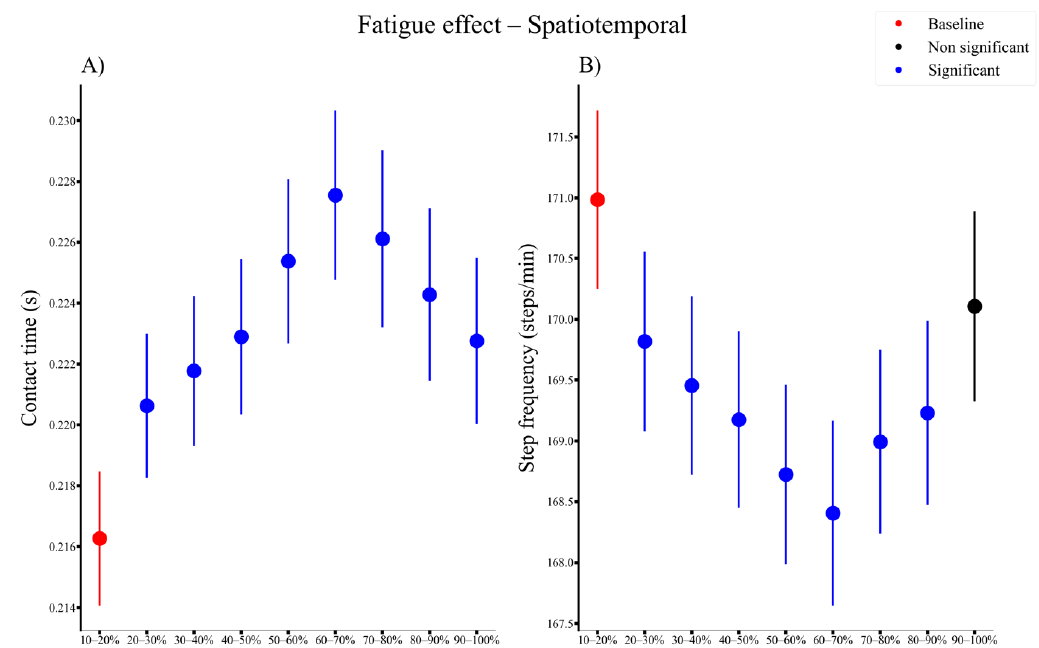
Figure 5. Time series of the overall significant fatigue effects (represented by blue dots) for spatiotemporal measures (( A ) contact time and ( B ) step frequency) for all participants compared to the baseline (represented by red dots). VT, vertical.